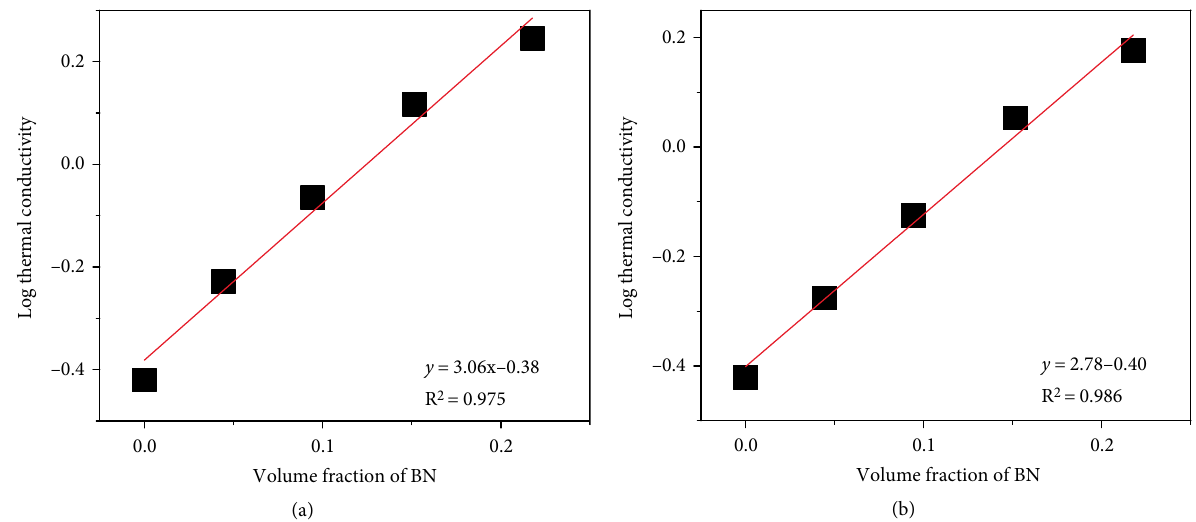
Figure 8: Logarithmic thermal conductivities of the UHMWPE composites as a function of the BN volume fraction by solvent mixing (a) and melt mixing